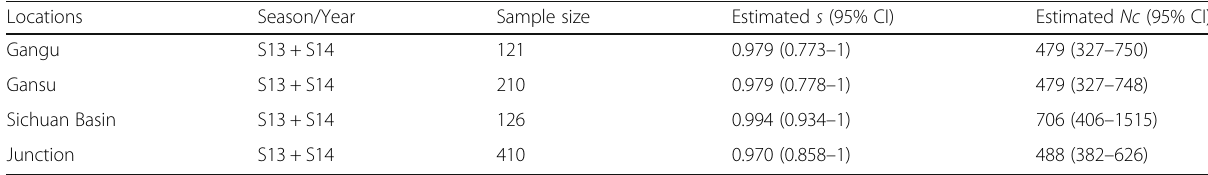
Table 2 Estimates of the frequency of sexual reproduction s and effective population size Nc